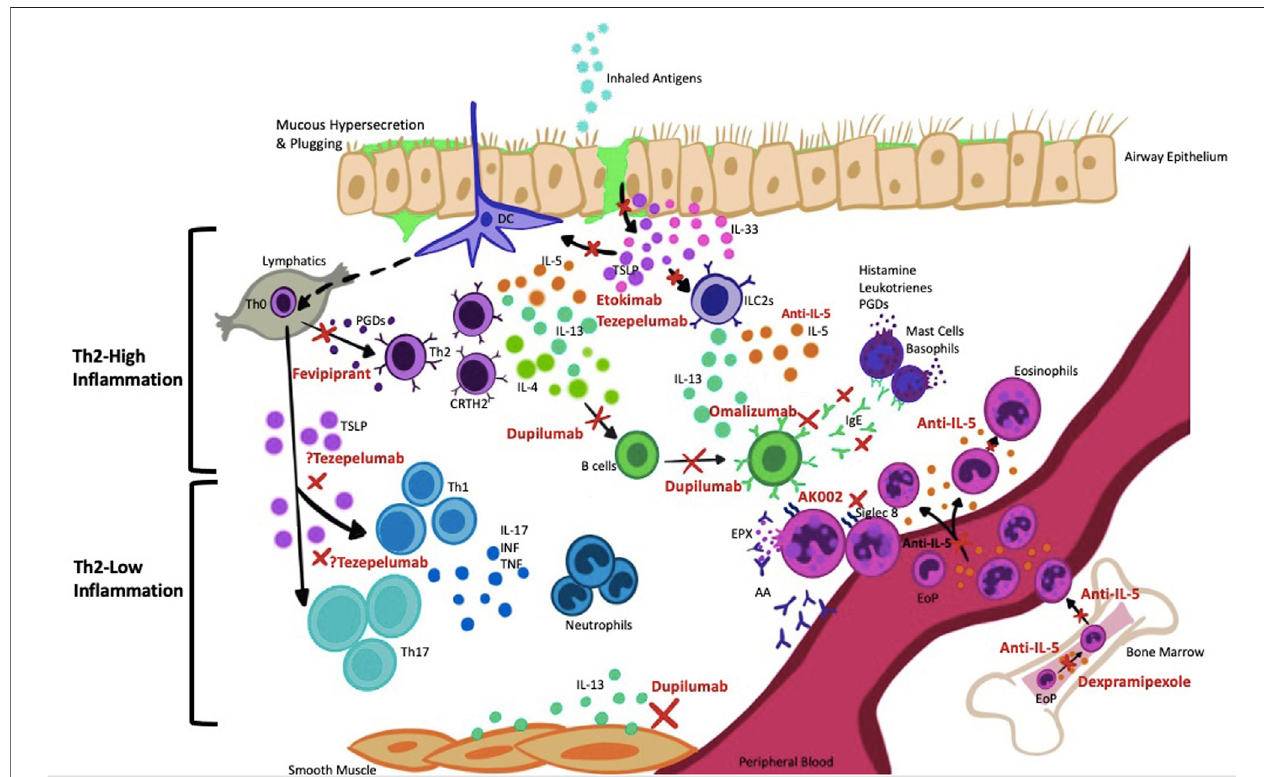
FIGURE1| Targetsofcurrenttherapyin severe asthma. There arenumerous targetsthathave been identi fi ed forthe management ofsevere asthma. Inparticular, the differentiation of eosinophil progenitors (EoP) into eosinophils, and subsequent activation of eosinophils can be targeted by anti-Siglec-8 (AK002), dexpramipexole, as well as anti-IL-5 therapies. The secretion of alarmin cytokines (TSLP, IL-33) from epithelial cells and activation of downstream ILC2s and Th2 cells can be inhibited by anti-TSLP and anti-IL-33 agents, such as tezepelumab and etokimab, respectively. The downstream action of Th2 cytokines, such as IL-4 and IL-13, produced primarilyfromTh2cells, ILC2sand basophilscanbeinhibitedbydupilumab. Thecross-linking ofIgEonFc ε R1receptorsonmastcellsandbasophilscanbeinhibitedby omalizumab,andthuspreventdegranulationofleukotrienes, histamine,andprostaglandins(PGDs).PGDsplayanimportant roleinbindingtoCRTH2 onILC2sand Th2 cells,promotingtheirmigrationandactivationwithintheairways.Thiscanbetargetedbyanti-CRTH2agentssuchasfevipiprant.Therearefewidenti fi edtargetsforTh2- low in fl ammation but anti-TSLP is a potential biologic acts on this pathway. Abbreviations: AA: Autoantibodies; EoP: Eosinophil Progenitors; ILC2s: Innate Lymphoid Type 2 Cells; INF: Interferon; PGDs: Prostaglandins; TNF: Tumor necrosis factor; TSLP: Thymic Stromal